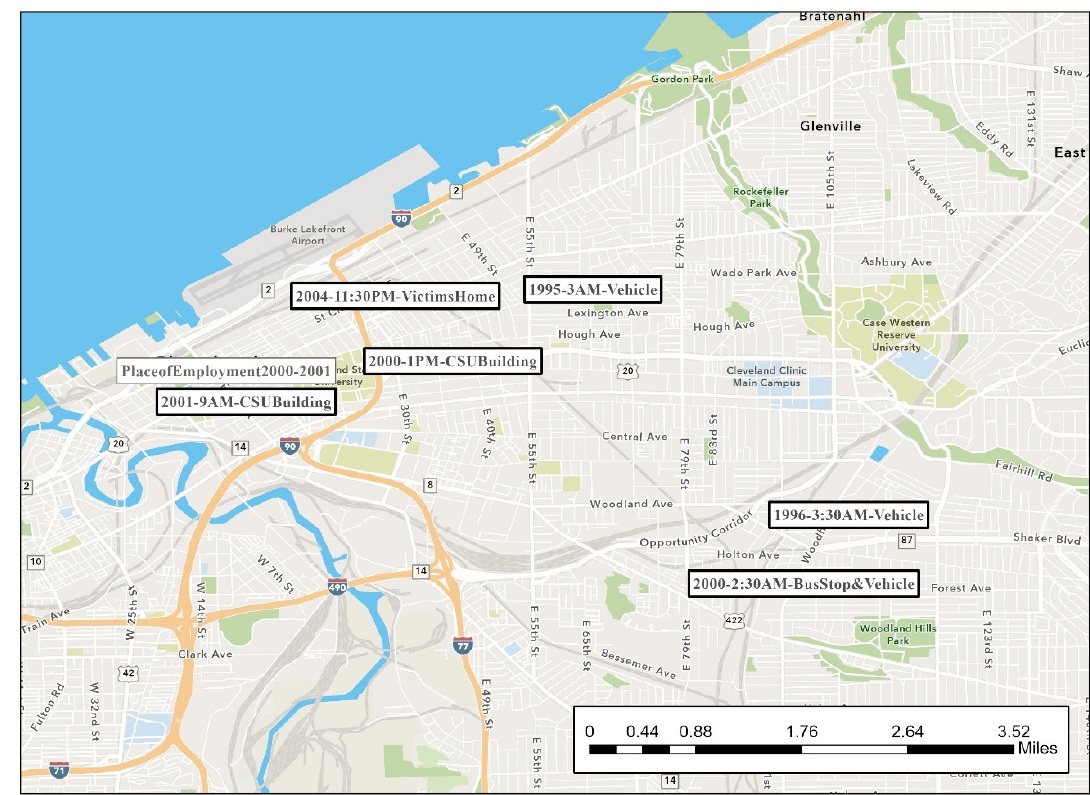
Figure 3. Cleveland’s East Side Sexual Assault Locations.